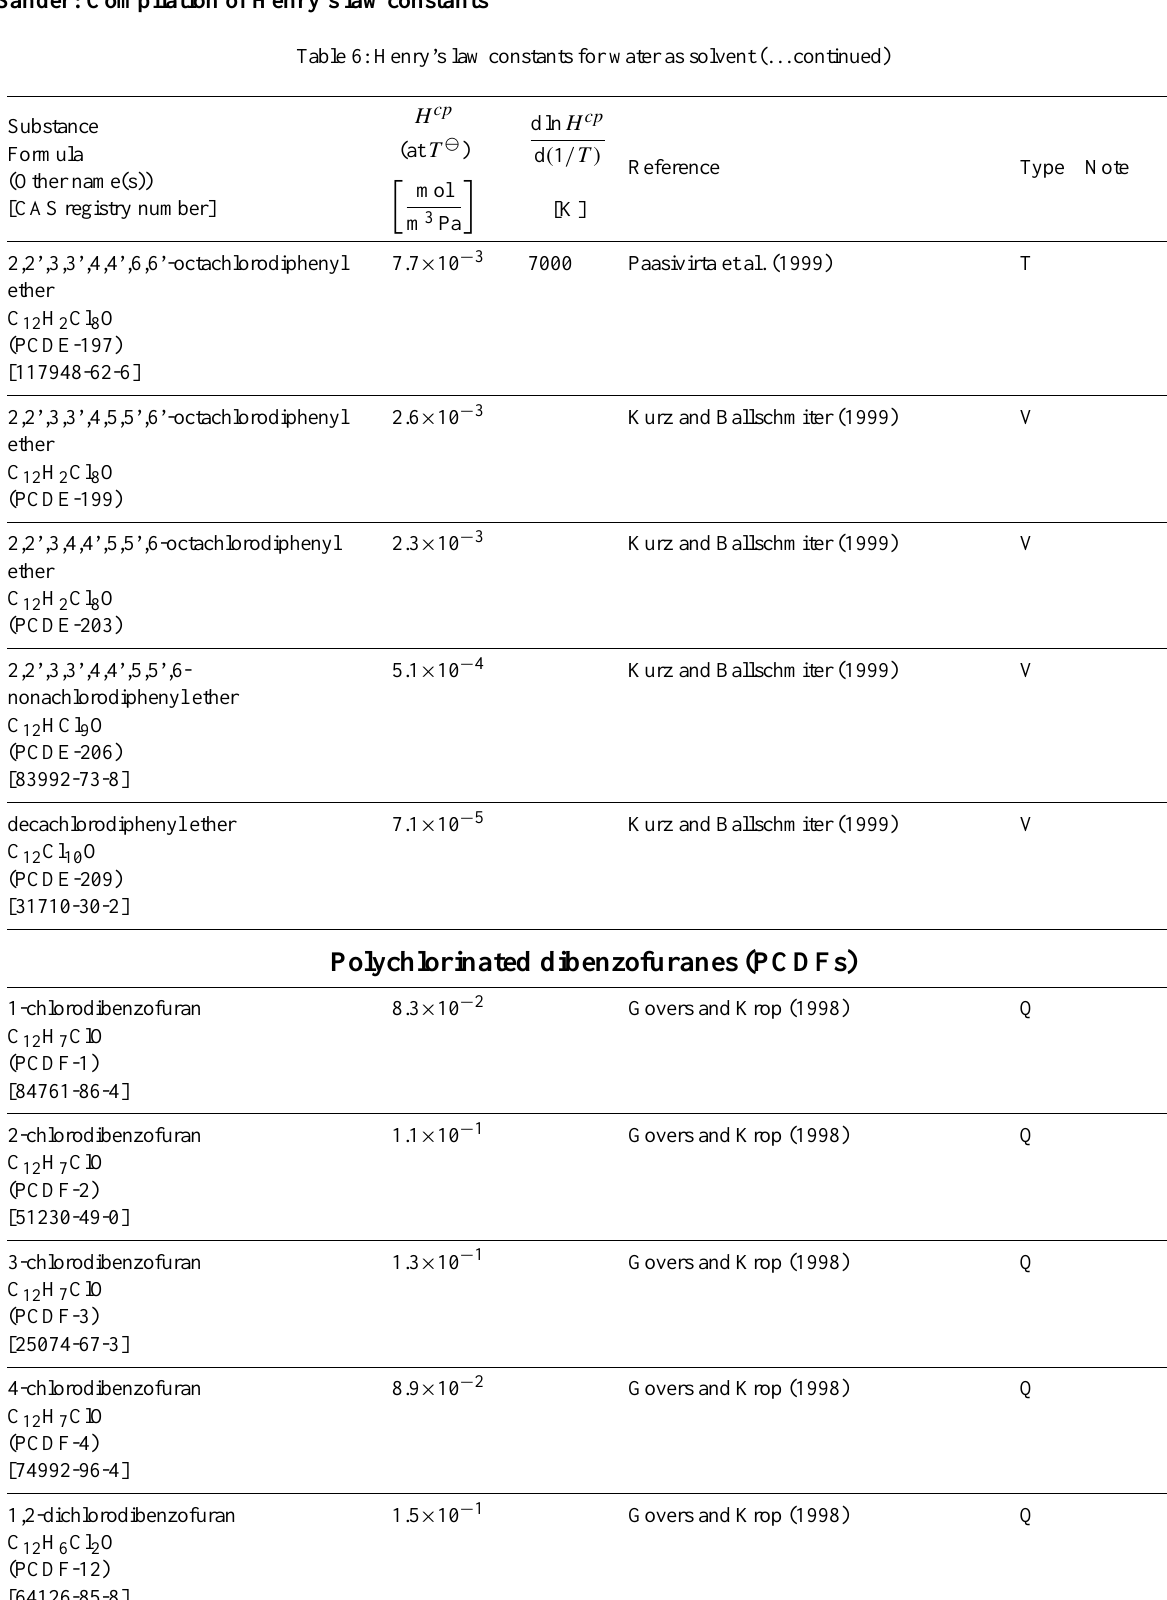
Table 6: Henry’s law constants for water as solvent